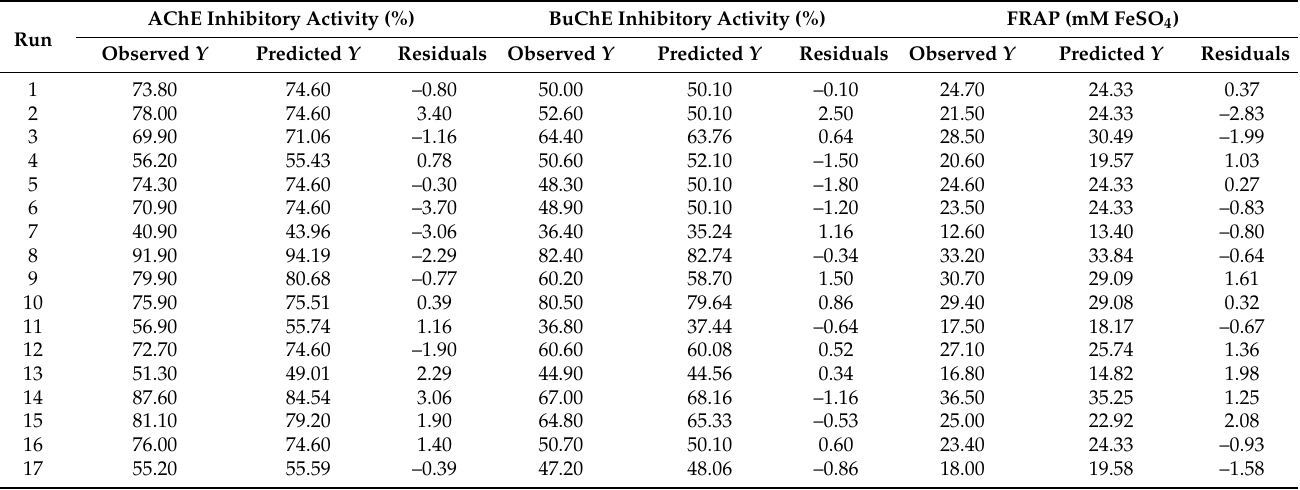
Table 4. Observed and predicted values for AChE, BuChE inhibitory activity (%), and FRAP (mM FeSO 4 ) of MKJW-fermented A. capillaris